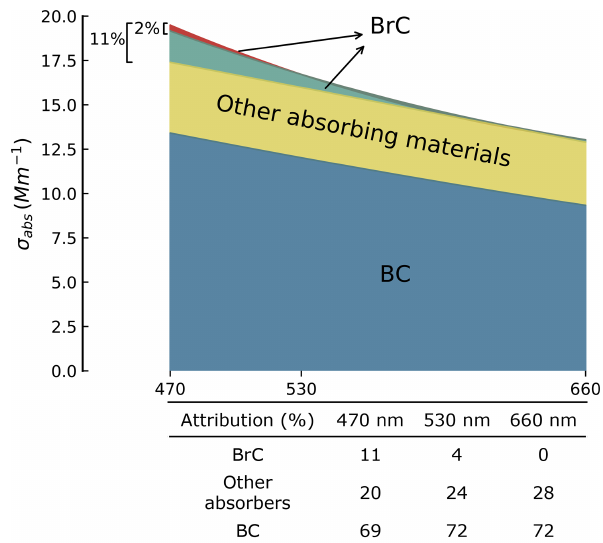
Figure 8. Illustration of the attribution of absorption for RF06_1. Blue area represents the absorption of BC, calculated with m BC = 1 . 95 + 0 . 79 i using BG model. The upper border of the yellow re- gion represents absorption coefficients calculated with correspond- ing m eBC for RF06_1 using BG model assuming non-absorbing OA; the yellow area illustrates the absorption by absorbing compo- nents besides BC and BrC, calculated as the difference between the two absorption coefficients calculated by the BG model using m eBC and m BC , respectively. The upper border of the red region is drawn with measured absorption coefficients at 470, 530, and 660nm. The red region stands for the BrC absorption coefficient calculated from the AAE attribution method with Eq. (13). The 2% and 11% are the proportions of BrC at 470nm estimated from the AAE attribu- tion method and our optical closure method, respectively. The table in the lower panel shows the absorption attribution at 470, 530, and 660nm from the optical closure method. Uncertainties can be found in Table S2 in the